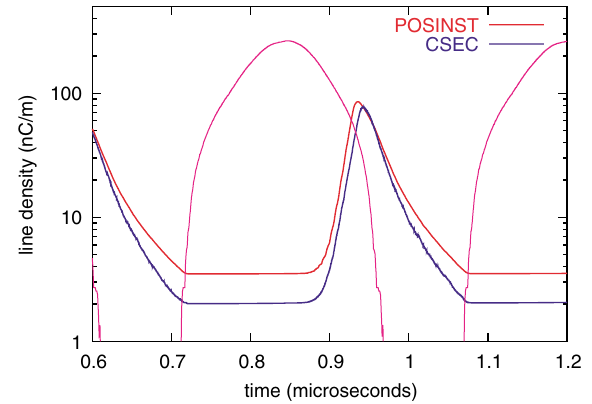
FIG. 6. (Color) Beam line density (purple) and total electron cloud line densities for the PSR obtained with CSEC (blue) and POSINST